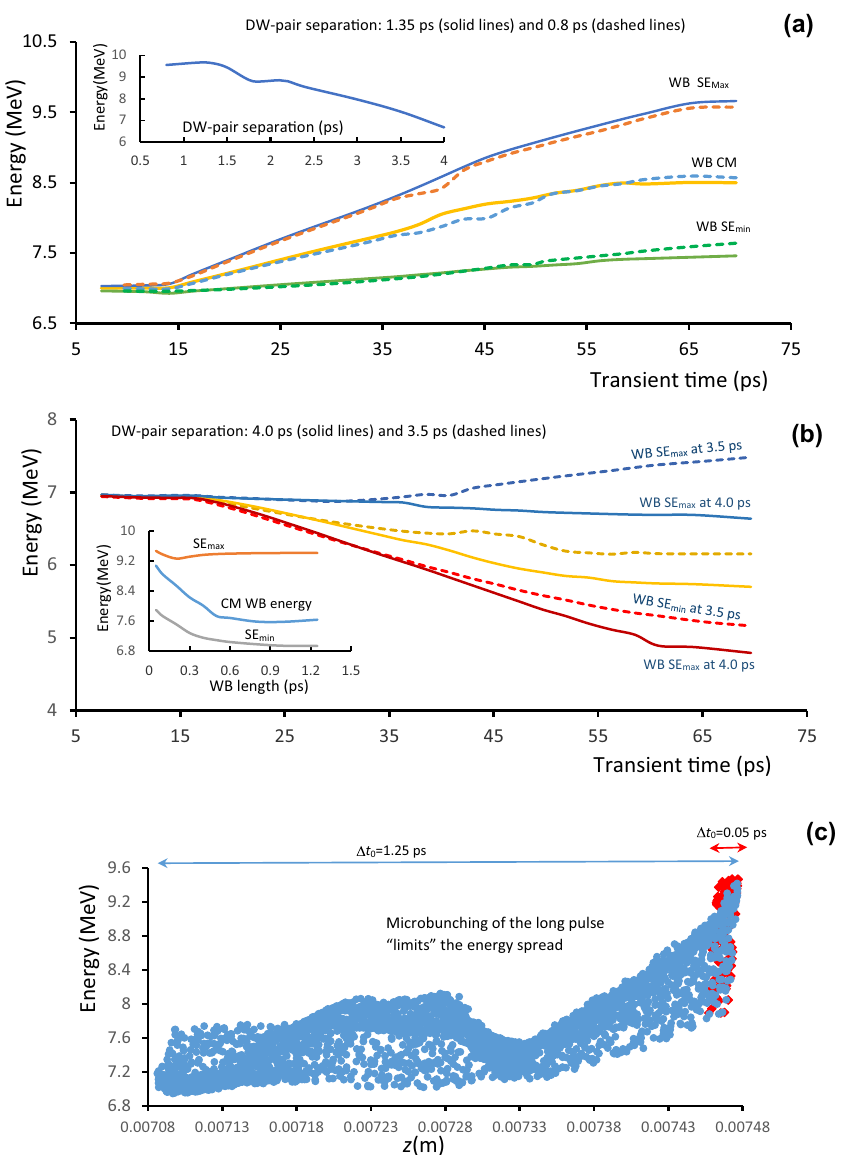
(a) DW-pair separa(cid:2)on: 1.35 ps (solid lines) and 0.8 ps (dashed lines)